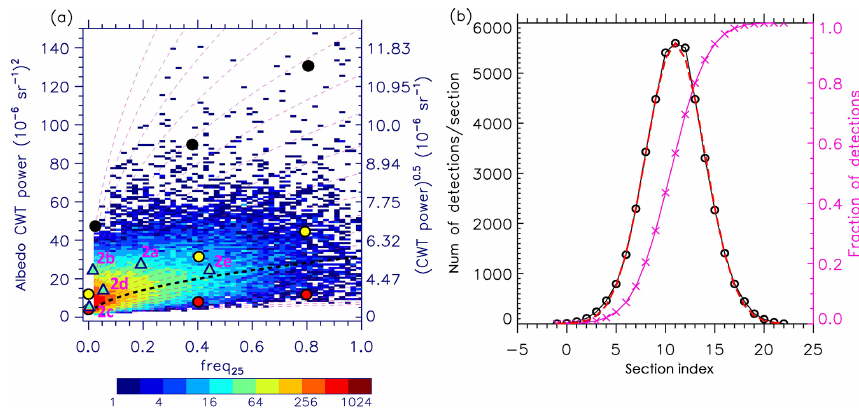
Figure 4. (a) Scatterplot of the wave detections to reflect the relationship between the bright-cloud frequency (freq 25 ) and the albedo CWT power. Only detections corresponding to the brighter clouds (freq 25 > 0 . 02) are included. The rainbow colors are the detection number density within each bin ( (cid:49) freq 25 = 0 . 02, and (cid:49) CWT = 1 . 0 × 10 − 12 sr − 2 ). The dashed thick black lines roughly follow the peaks of the detection number density isopleths, serving to derive an analytic relationship between the cloud brightness and the CWT power. The turquoise triangles correspond to the concentric waves shown in Fig. 2. The colored dots are selected roughly at the two tails and the peak of the normal distribution and at three brightness levels of freq 25 = 0, 0.4, and 0.8. These nine selections are representative of the full set of wave detections, to further demonstrate the wave exhibition in Figs. 7–9. Using a sequence of analytic curves (magenta dashed) to resample the wave detections, we obtain a normal distribution as is shown in (b) . In (b) the black curve with the circles represents the obtained distribution from the left panel, while the dashed red curve is the Gaussian fit. The magenta curve with crosses is the accumulated fraction of the data